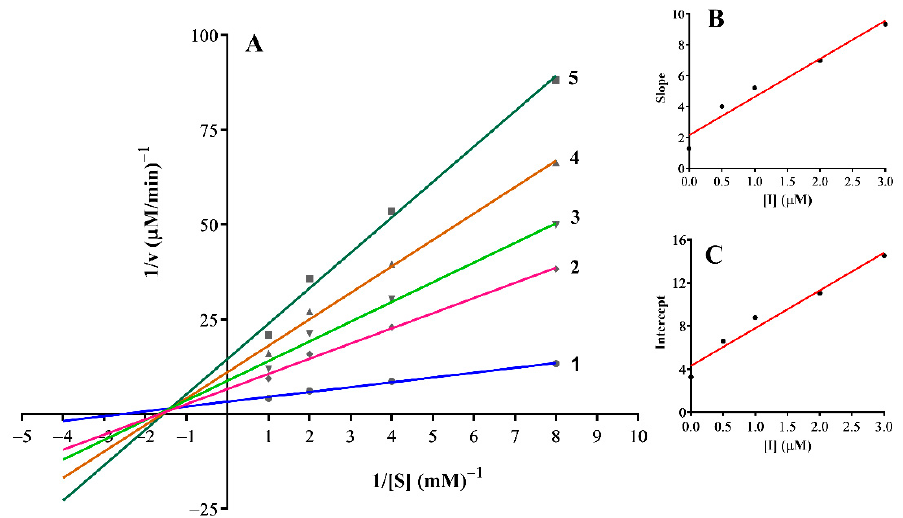
Figure 4. ( A ) Lineweaver − Burk plots for the inhibition of 12 on the mushroom tyrosinase for the catalysis of L-tyrosine at 28 °C, pH 6.8. Concentrations of 12 for curves 1–5 were 0.0, 0.5, 1.0, 2.0 and 3.0 µ Μ , respectively. The insets ( B , C ) represent the secondary plot of the slopes and intercepts versus concentrations of 12 to determine the inhibition constants.